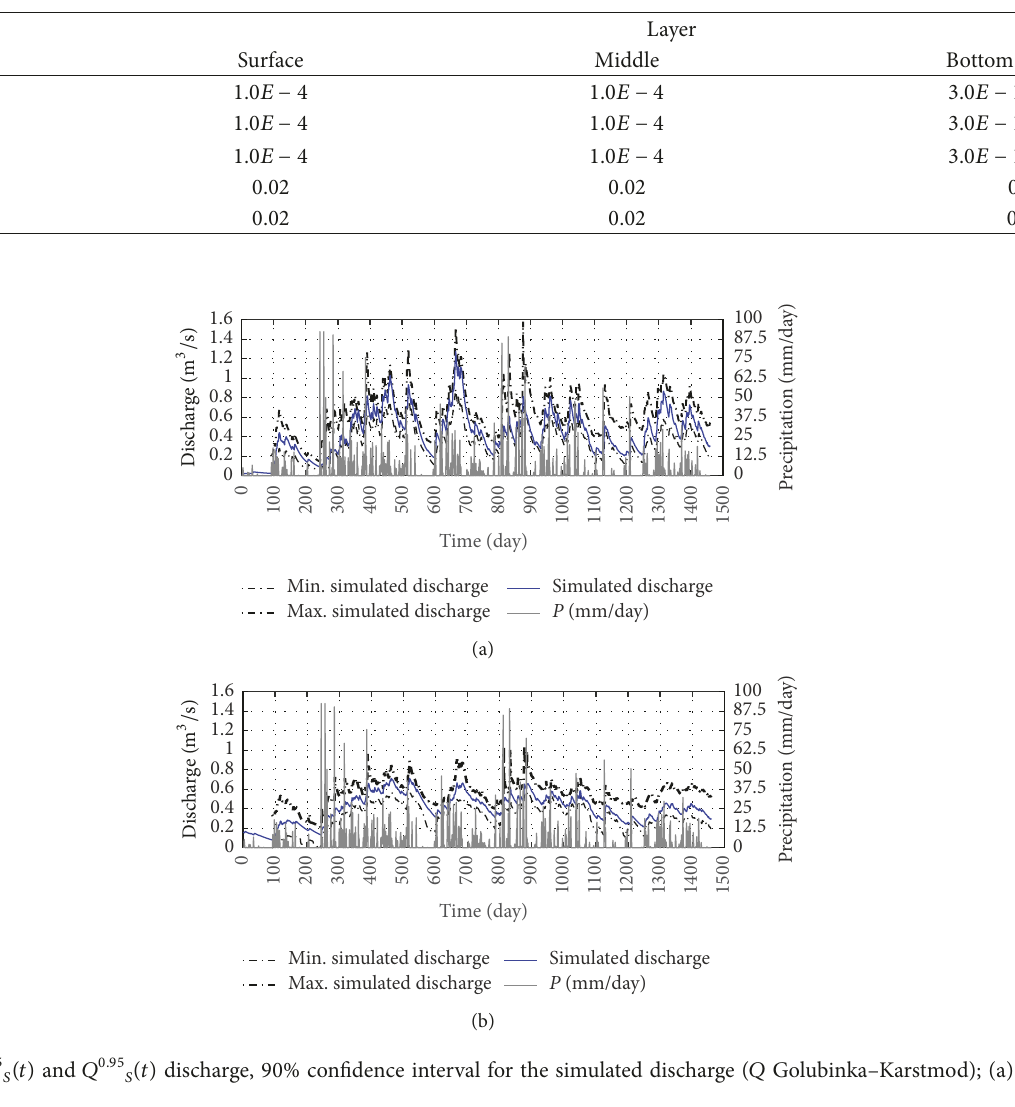
Table 3: Adopted hydraulic conductivity values 𝑘 𝑥,𝑦,𝑧 , the effective porosity coefficient 𝑛 eff , and the total porosity coefficient 𝑛 tot , based on the calibration procedures relied on in the piezometer 𝑃1 groundwater level hydrograph.